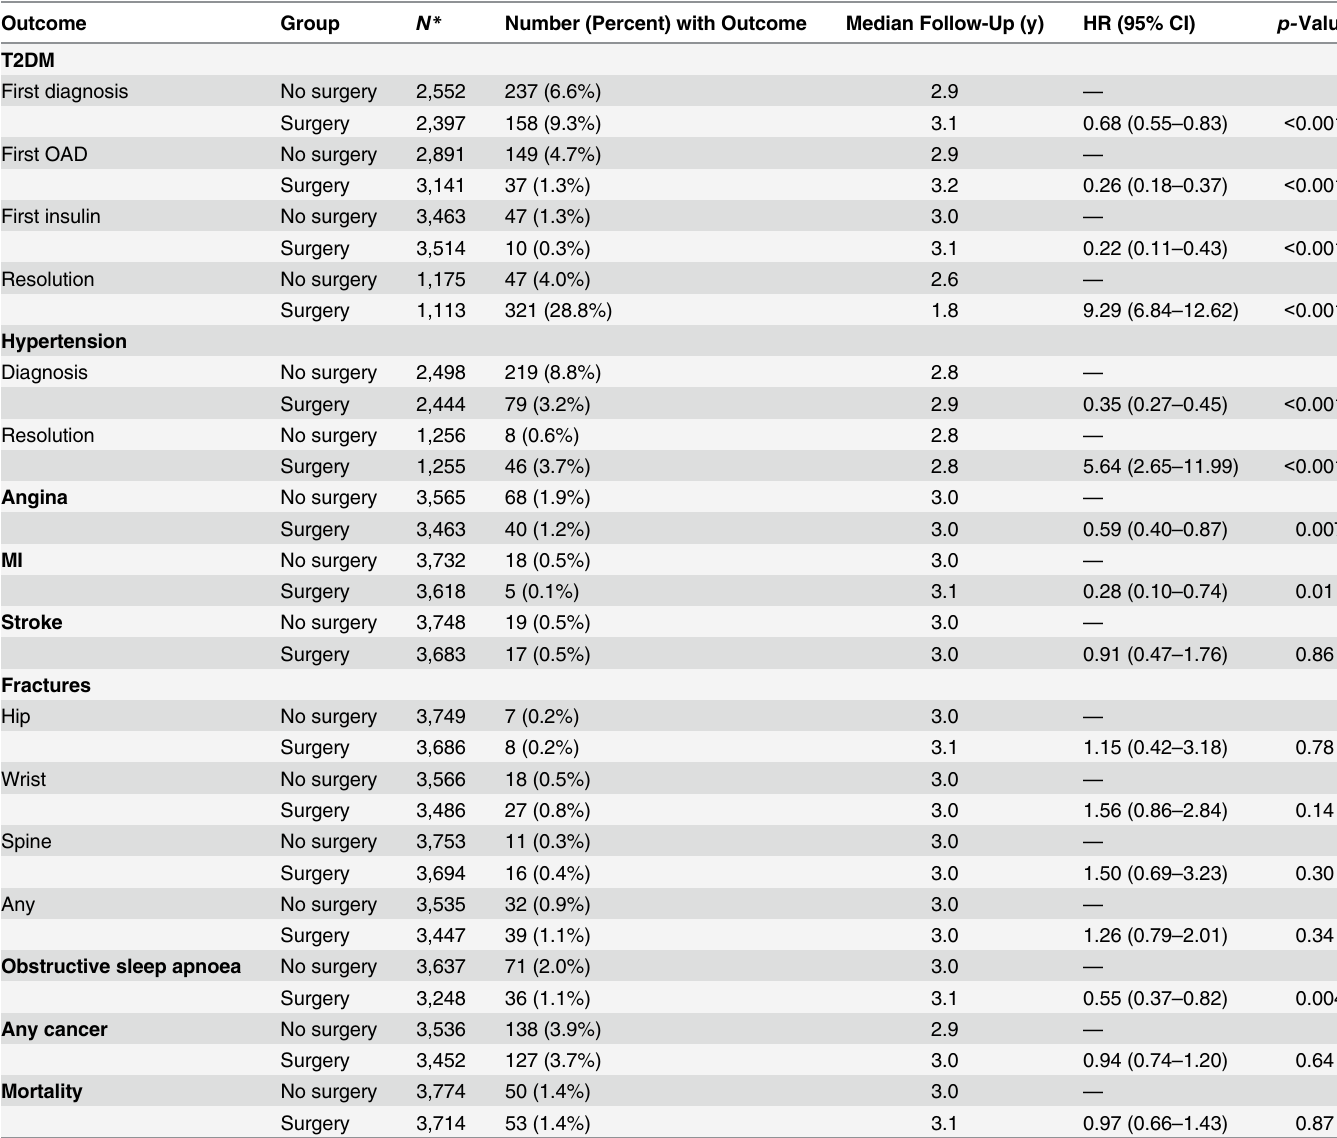
Table 3. Association between bariatric surgery and health outcomes.